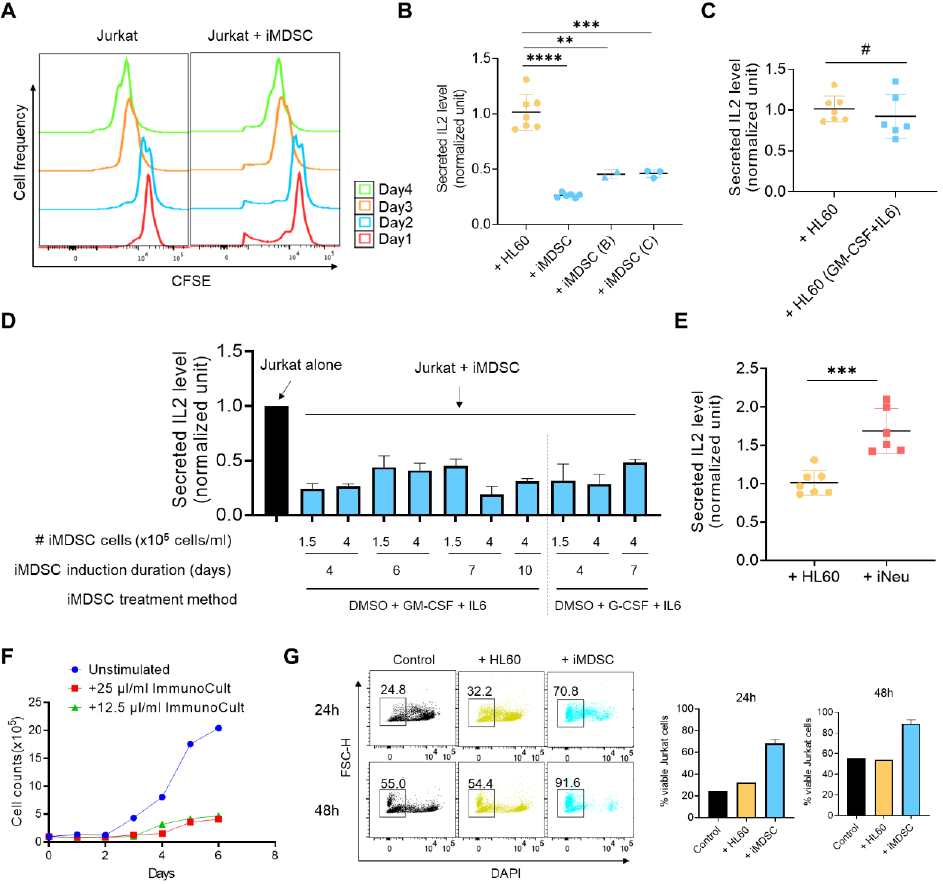
Figure 3. iMDSC suppress IL2 secretion and activation-induced cell death in stimulated Jurkat cells.